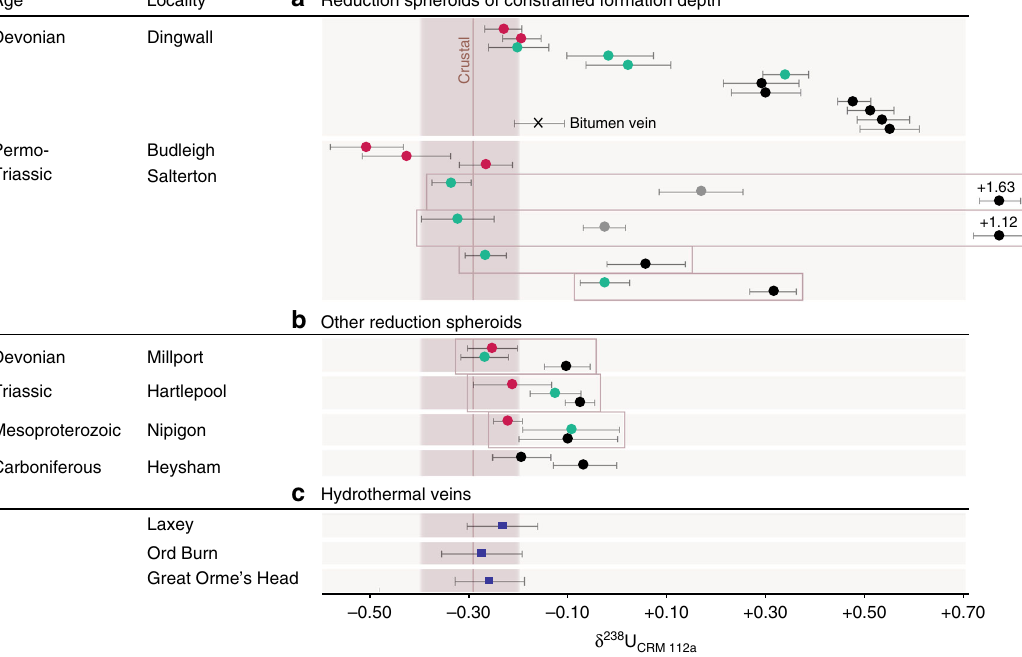
Table 1). Uranium activity ratios (234U/238U) are given in Supplementary Table 1 and Supplementary Figure 2.